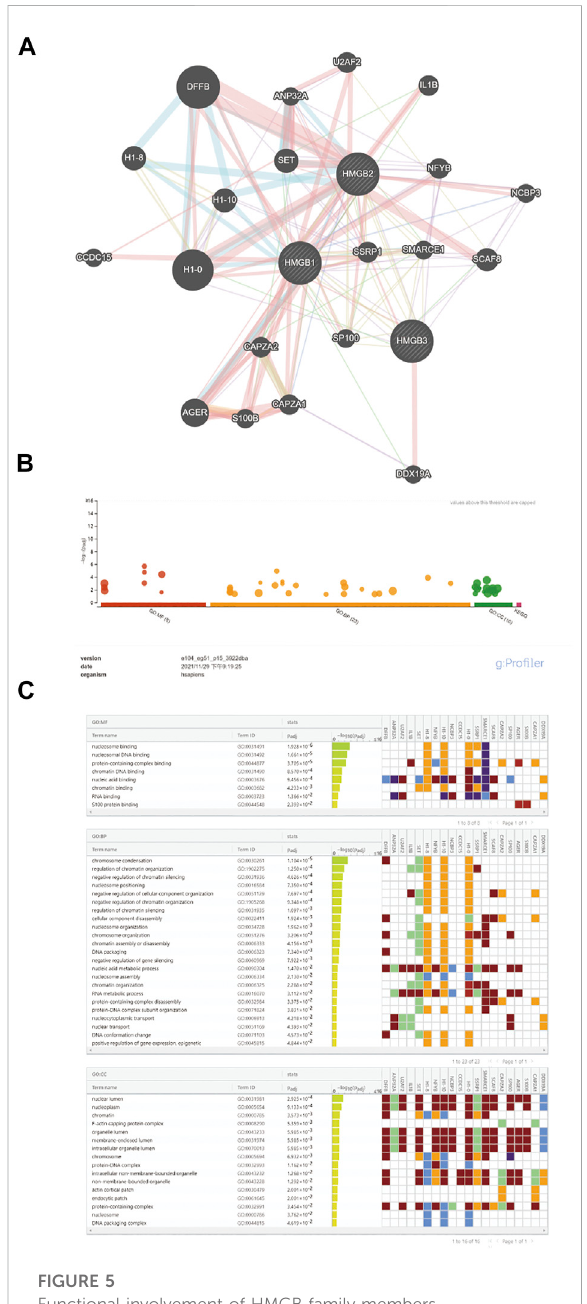
FIGURE 5 Functional involvement of HMGB family members. GeneMANIA was used to predict the function of HMGB family and GO and KEGG analysis were performed to fi nd related genes and pathways. (A) Schematic diagram of protein and genetic interactions, pathways, and co-expression of HMGB family members. (B,C) GO and KEGG analysis